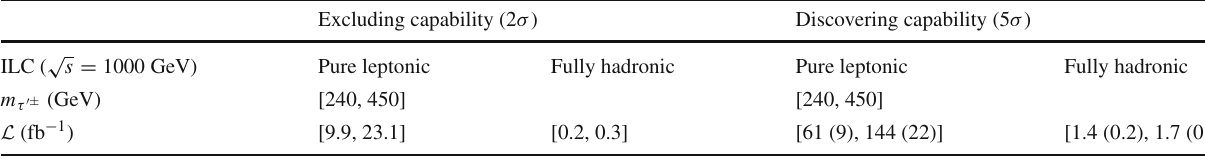
Table 13 Same as Table 12 but for